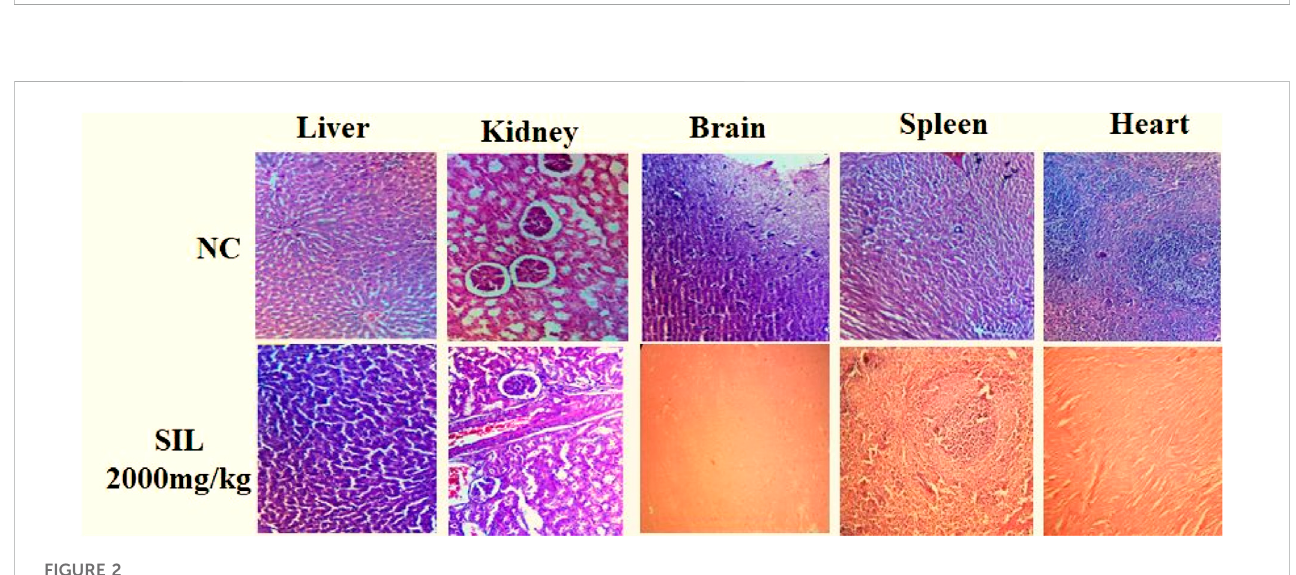
Histogram of selected organs in treated groups in acute toxicity